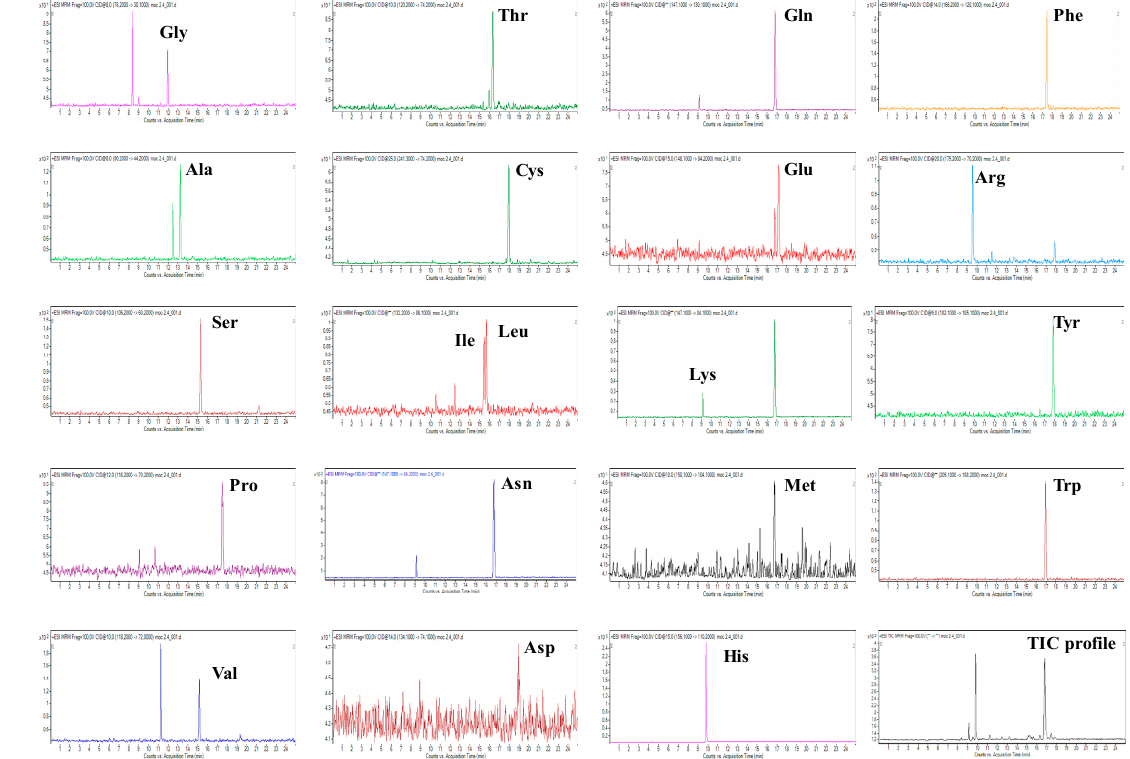
Figure3. Extractedanalyticalprofilesofclinicalsample. Multiplereactionmonitoring(MRM)transitions Figure 3. Extracted analytical profiles of clinical sample. Multiple reaction monitoring (MRM) from the CE-MS / MS analysis of a 10-fold diluted human urine sample obtained from a patient su ff ering transitions from the CE-MS/MS analysis of a 10-fold diluted human urine sample obtained from a from inflammatory bowel disease undergoing treatment with thiopurines (azathioprine). For the patient suffering from inflammatory bowel disease undergoing treatment with thiopurines sample preparation and other working conditions, see Section 3. (azathioprine). For the sample preparation and other working conditions, see Section 3.